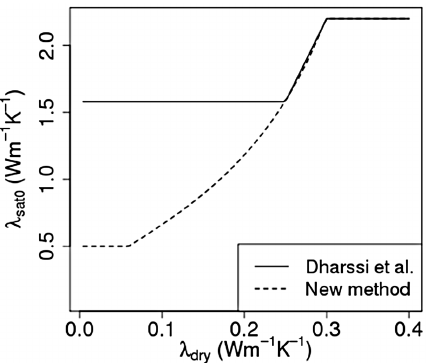
Figure 1. New method of calculating saturated thermal conductiv- ity ( λ sat0 ) from dry thermal conductivity ( λ dry ), compared with the standard method. See Appendix A, Eq. (A10) for the Dharssi pa- rameterisation and Appendix A, Eq. (A11) for the new method, which is modified to include organic